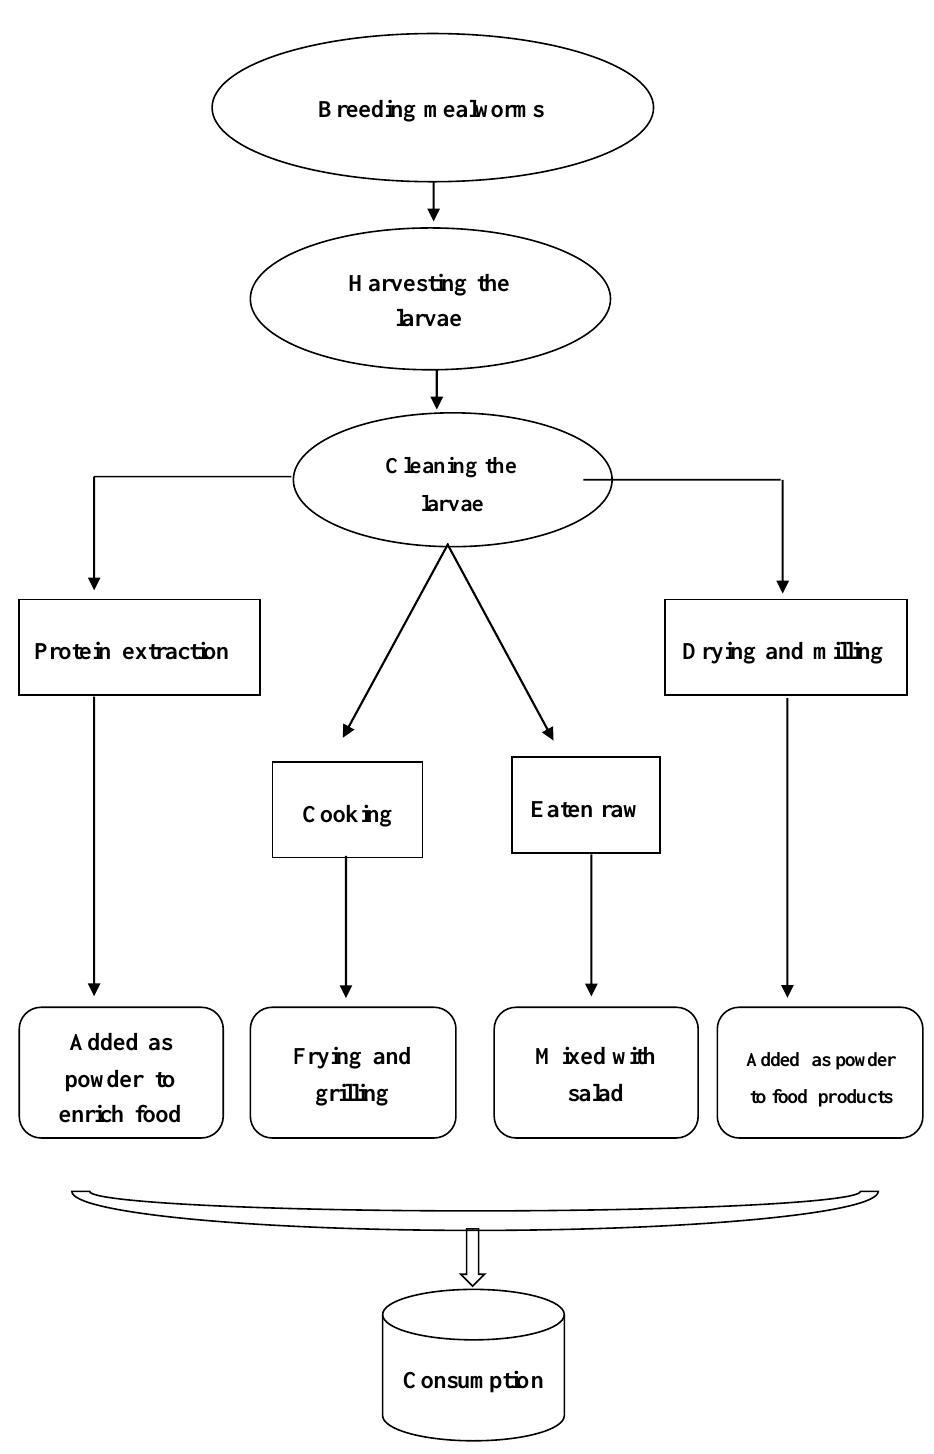
Figure 4. Main steps from farm to consumer in the use of mealworms as human food.